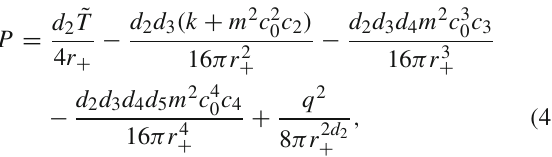
Fig. 22 Spherical black hole inLovelock gravity: P − r + (left), T − r + (middle)and G − T (right)diagrams;wehaveset k = + 1, d = 8, q = 1, and α = 0 . 01. Left panel: T < T c (continuous lines), T = T c (dotted